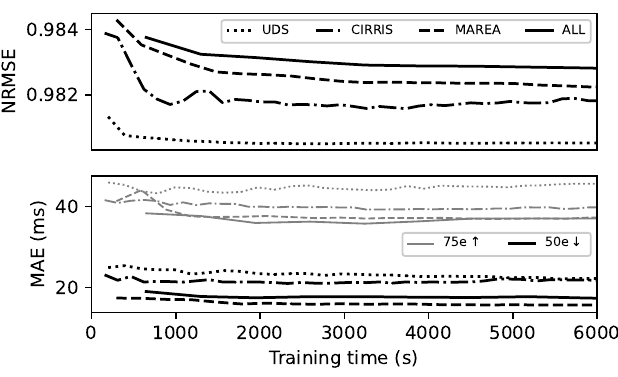
Figure 7. NRMSE and MAE as a function of the length of the training set (with the AP axis acceleration input) considering all events for each database. The errors were evaluated using the MAR all , CIR all and UDS all subsets. The three subsets were considered together in the set ALL, with the HS and TO gait event types only. The MAE and NRMSE are different for all databases, mostly because of the harder and higher number of gait event types detected in the CIRRIS and UDS databases than in the